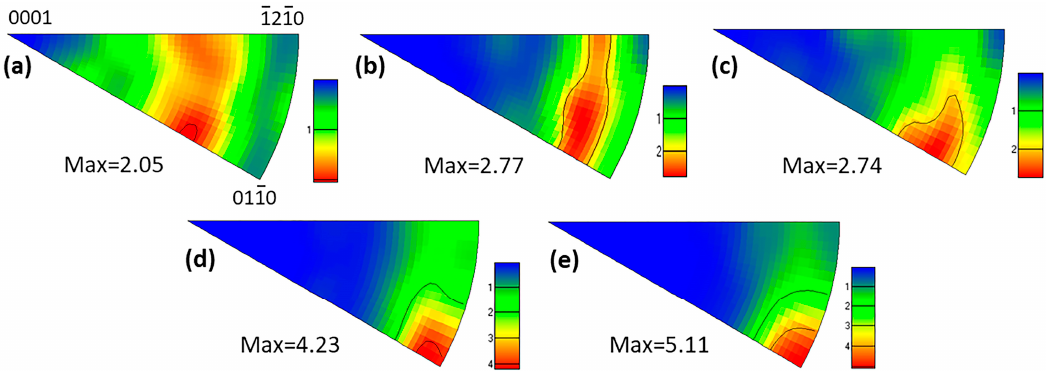
Figure 8. EBSD IPF maps of as-extruded alloys: ( a ) Alloy1, ( b ) Alloy2, ( c ) Alloy3, ( d ) Alloy4 and ( e ) Alloy5.